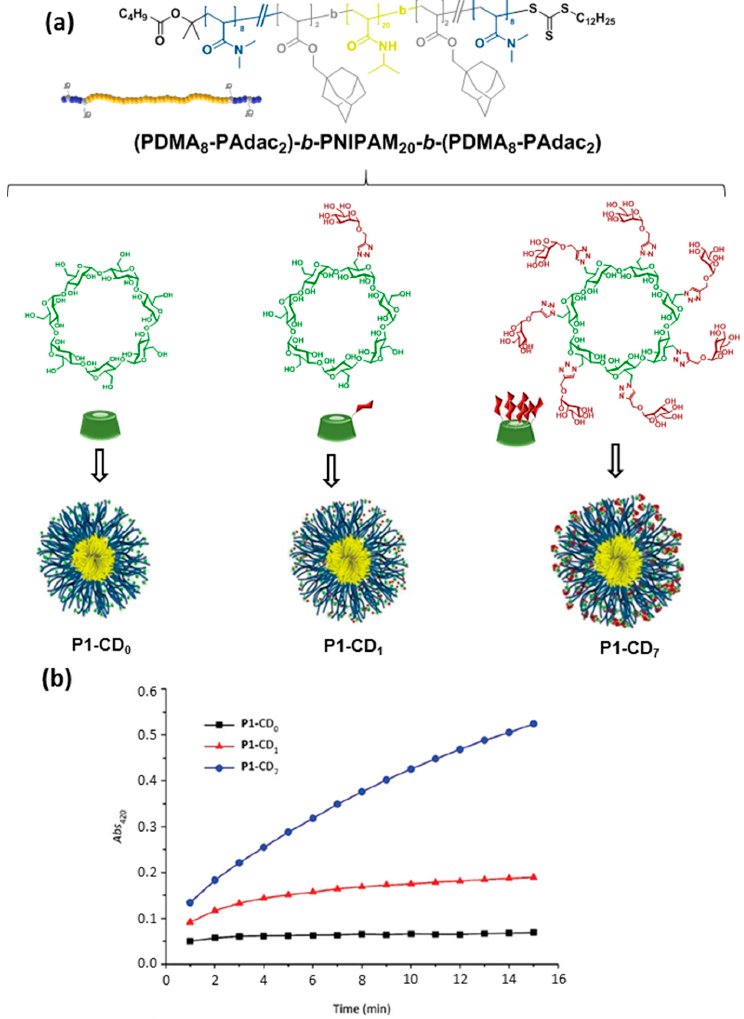
Figure 7. Average structure of the triblock copolymer (P1) and structures of the β CD derivatives used by Bercer and coworkers [61] to self-assemble glycomicelles trough equimolecular mixing in water ( a ) and turbidity plots obtained upon mixing with concanavalin A (ConA) at 40 °C ( b ). Adapted with permission from Reference [61]. Copyright 2016 Royal Society of Chemistry. PDMA, poly( N , N -dimethylacrylamide); PNIPAM, poly( N -isopropyl acrylamide); PAdac, poly(adamantane-acrylate).